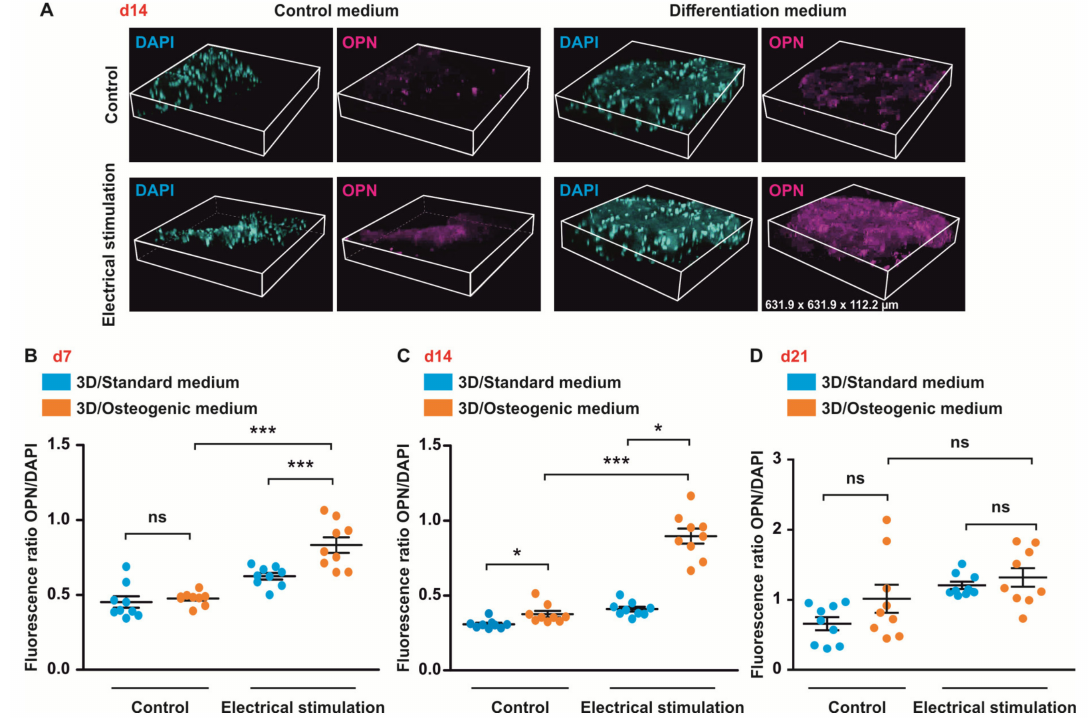
Figure 7. Electrical stimulation (ES) increases expression of osteopontin (OPN) in 3D at d7 and d14. ASCs were cultivated in standard or osteogenic medium with and without electrical stimulation (ES) for up to 21 days. ( A ) 3D reconstruction of z-sections. ( B – D ) Quantification of the data. ES resulted in increased expression of OPN in cells under osteogenic conditions at d7 and d14. At d14, higher expression level of OPN was observed in cells in osteogenic medium under ES exposure compared to cells under osteogenic conditions without ES. No significant di ff erences in OPN expression were found at d21. Error bars: SEM. * p < 0.05, ** p < 0.01, *** p < 0.0001. ns: not